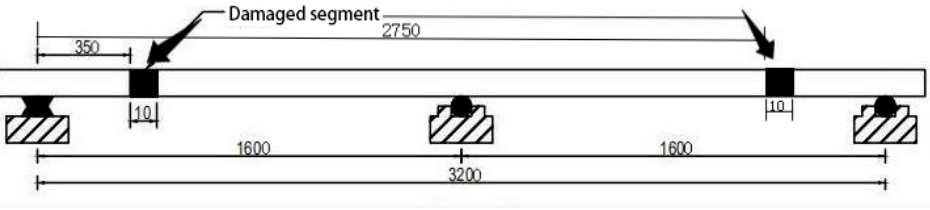
Figure 7. Diagram of work condition Model 1. Table 1. Damage information of Condition 1.